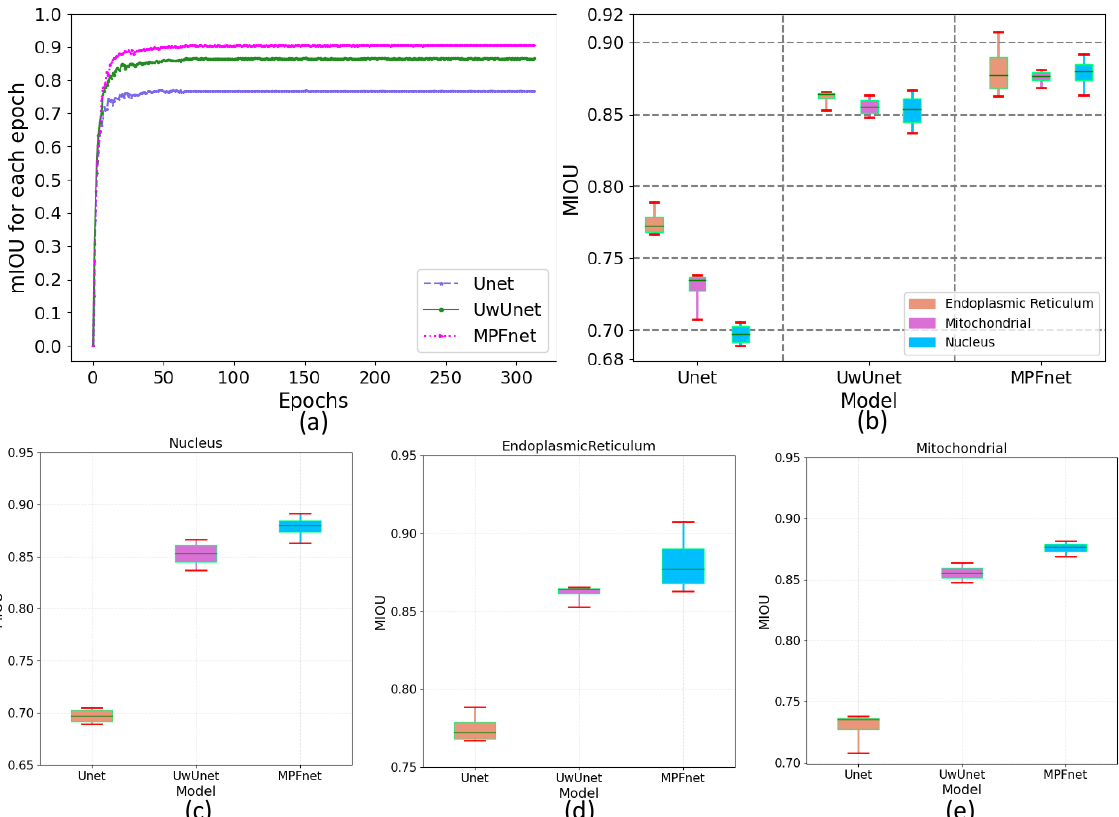
Figure 6. The mean intersection over union (mIOU) of different deep learning models over all SRS microscopy images in fixed lung cancer cells (A549, from ATCC) detection dataset. ( a ) mIOU for each epoch comparison among different methods. Unet (Purple triangle dash line), UwUnet (Green circle solid line), MPFnet (Pink arrow dotted line) represent Unet, UwUnet, MPFnet, respectively. ( b ) Box plot of mIOU accuracy of all organelles (nuclei, mitochondria, and endoplasmic reticulum) prediction task set with MPFnet-based learning model and compared with that of varied deep neural network-based prediction models, such as Unet and UwUnet learning models. ( c ) Box plot of mIOU accuracy on nuclei prediction task set with MPFnet-based learning model and compared with that of varied deep neural network-based prediction models such as Unet and UwUnet learning model. ( d ) Box plot of mIOU accuracy on endoplasmic reticulum prediction task set with MPFnet-based learning model and compared with that of varied deep neural network-based prediction models such as Unet and UwUnet learning model on all. ( e ) Box plot of mIOU accuracy on mitochondria prediction task set with MPFnet-based learning model and compared with that of varied deep neural network-based prediction models such as Unet and UwUnet learning models.